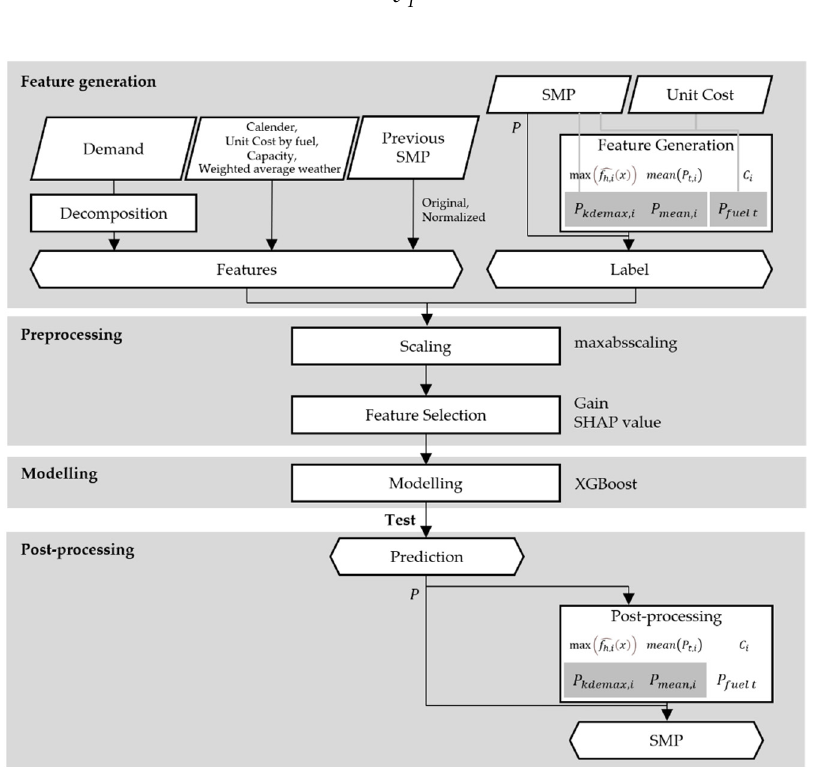
Figure 1. Process of forecasting.